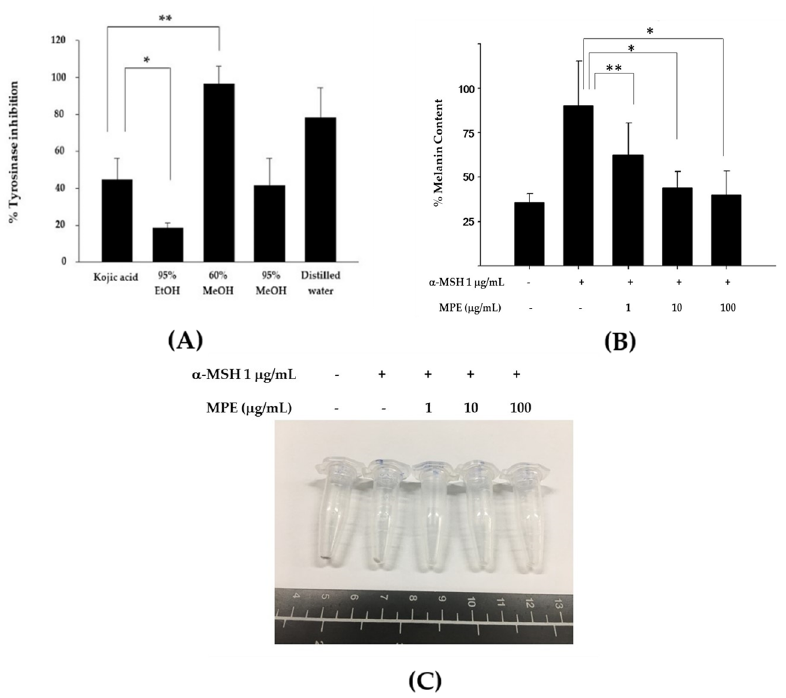
Figure 1. Melanin production after treatment of Musa (AA) ‘Leb Mu Nang’ dried peel extracts ( A ) Free mushroom tyrosinase assay of peel extracts (100 µ g/mL) using 95% EtOH, 60% MeOH, 95% MeOH, and distilled water (mean ± SD, n = 7) ( B ) Melanin content in B16F10 mouse melanoma cells after treatment with MPE (0–100 µ g/mL) and α -MSH for 24 h (mean ± SD, n = 7); * p < 0.01; ** p < 0.05. ( C ) Precipitated B16F10 mouse melanoma cells after treatment with MPE (0–100 µ g/mL) and α -MSH for 24